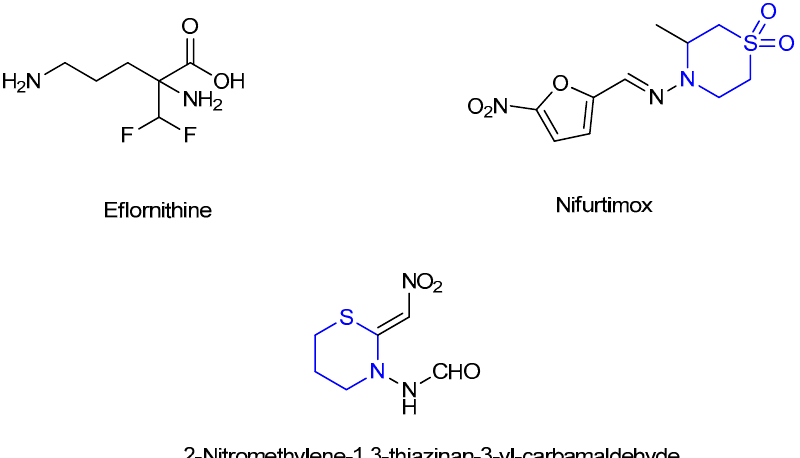
Figure 4. Molecular structure of some bioactive thiazinane derivatives.